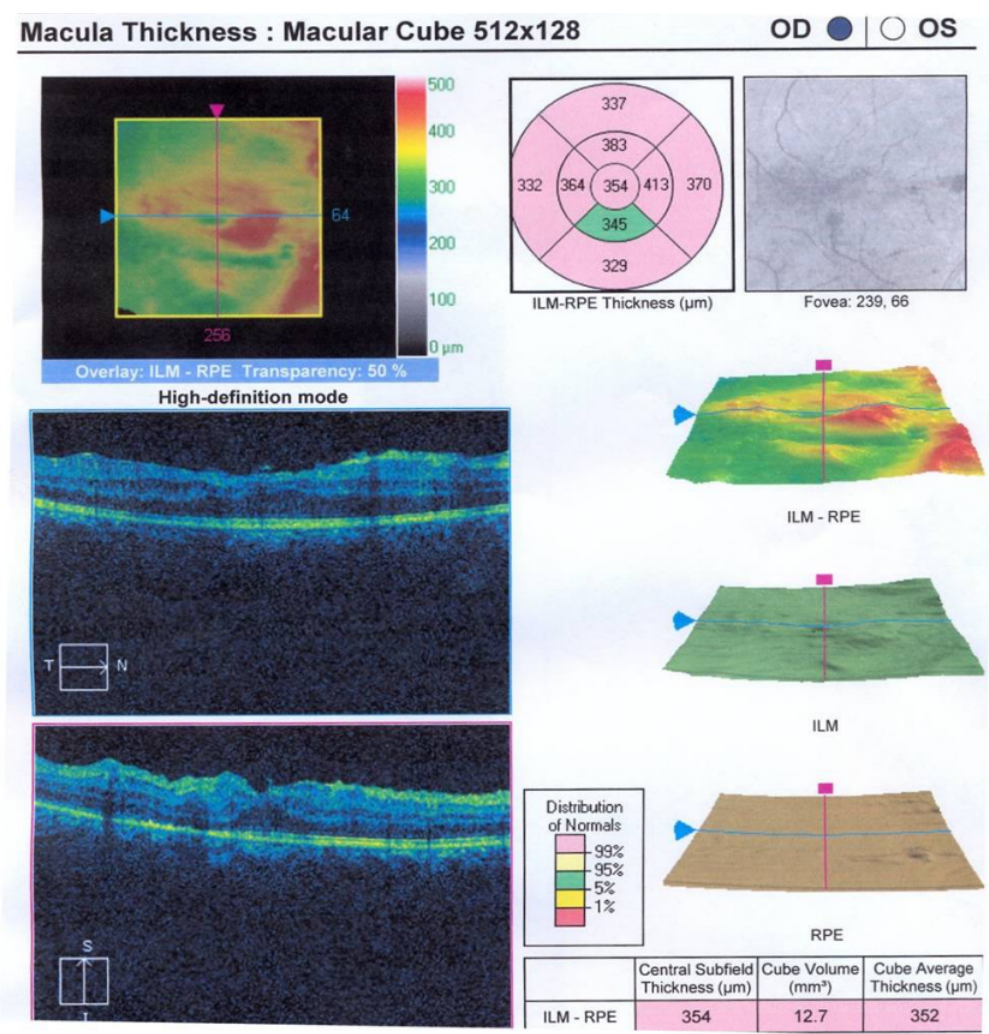
Figure 7: Right eye macular OCT demonstrates significantly reduction of macular thickness after treatment with intravitreal bevacizumab